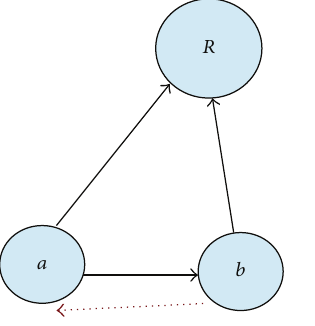
Figure 13: Node 𝑎 has now two paths to the root, but node 𝑏 has just one. Creating a second path for node 𝑏 by adding an edge directed to node 𝑎 will create a cycle.